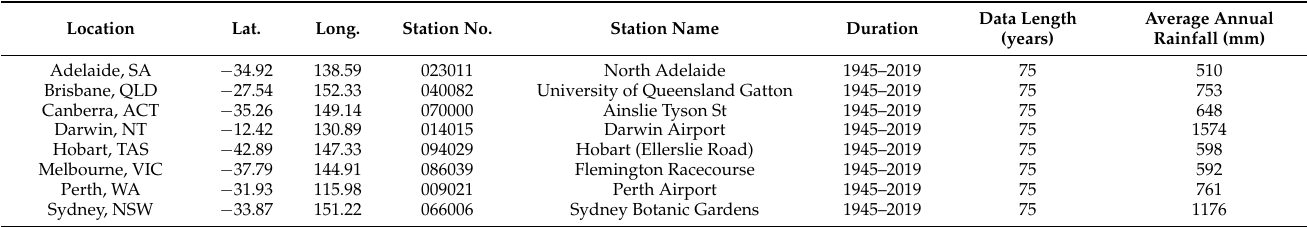
Figure 1. Location of the selected rainfall stations and spatial distribution of mean annual rainfall. Table 1. Summary of selected daily rainfall data.